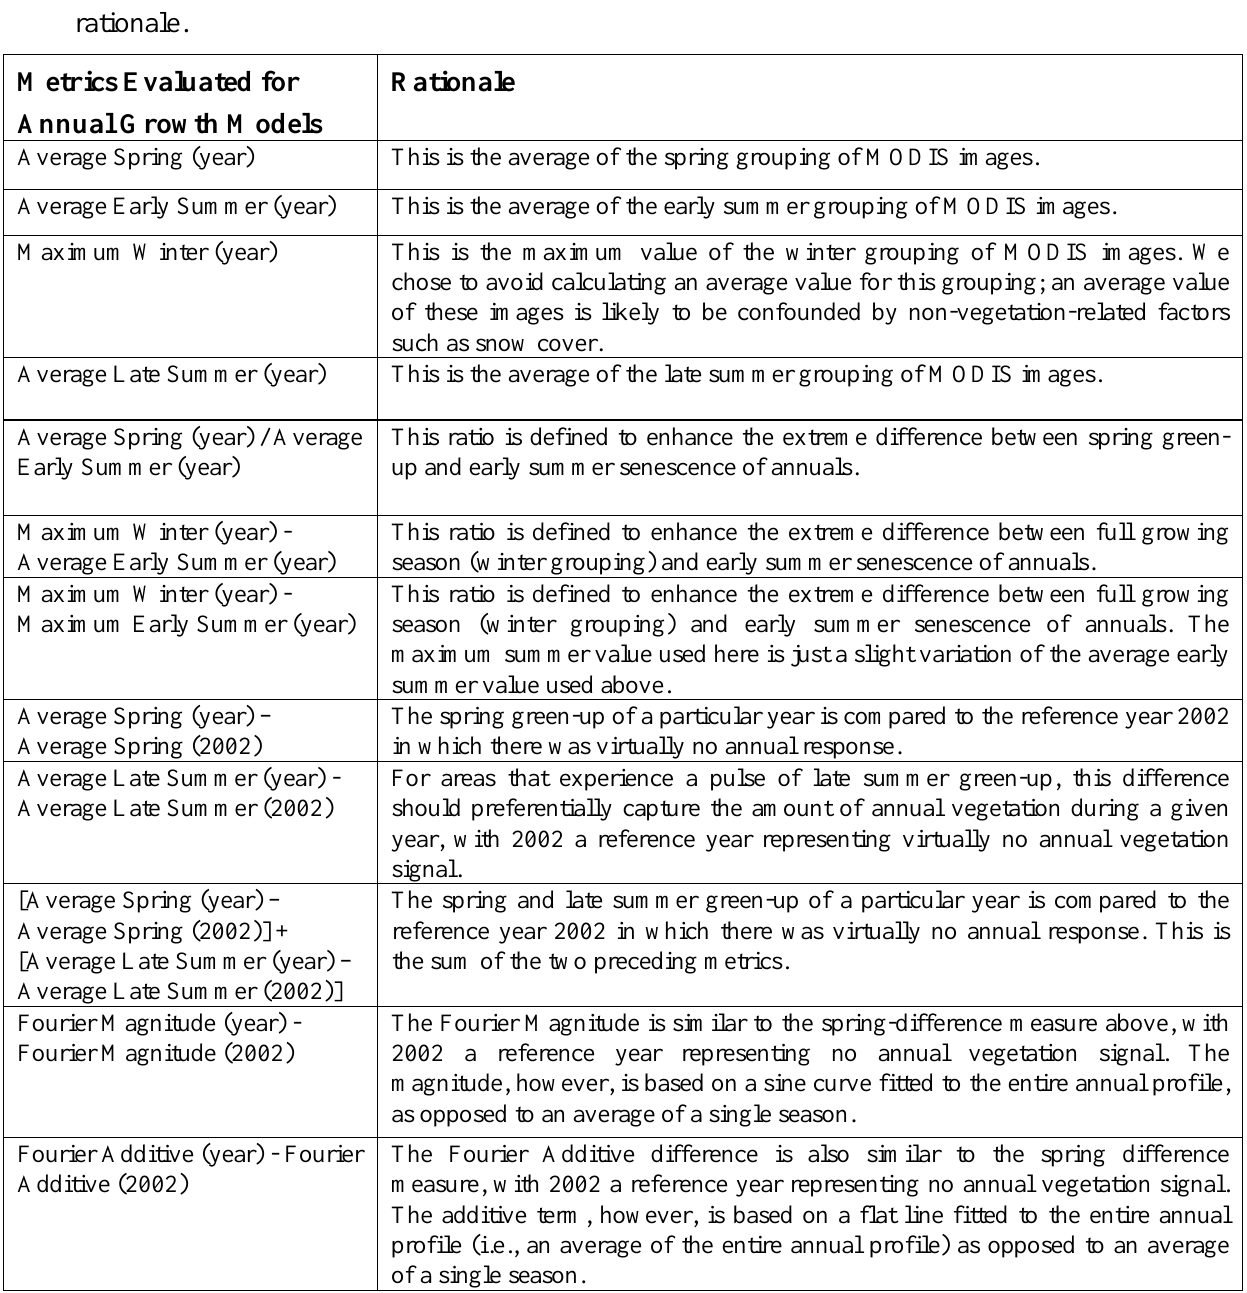
Table 1. Metrics tested to capture annual growth in the Mojave Desert, with supporting